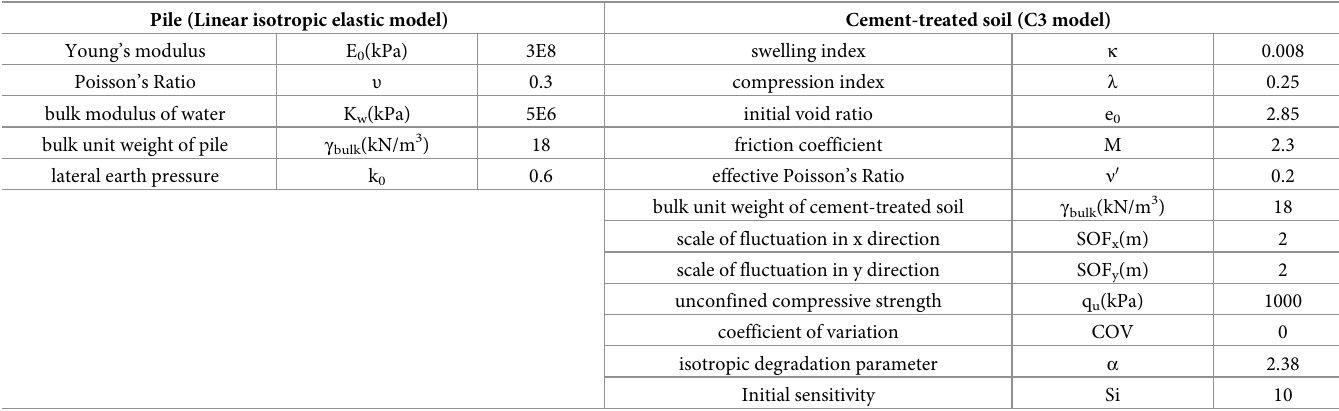
Table 1. Mode parameters.